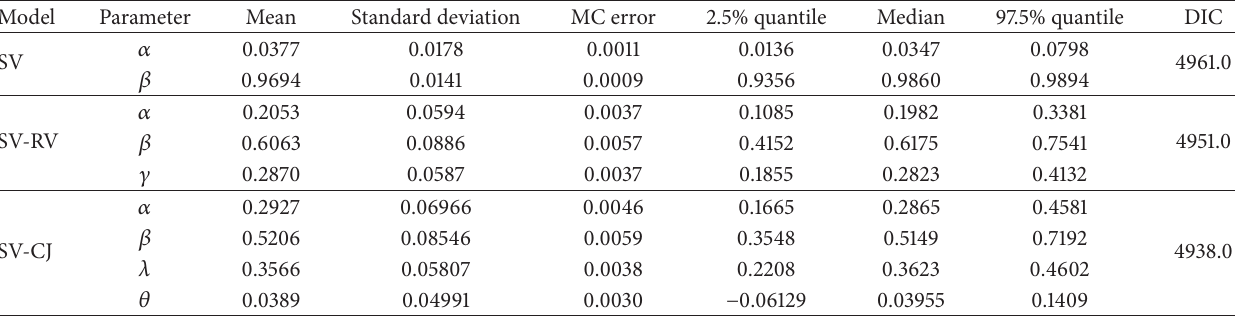
Table 2: The estimation results of the SV, SV-RV, and SV-CJ model.